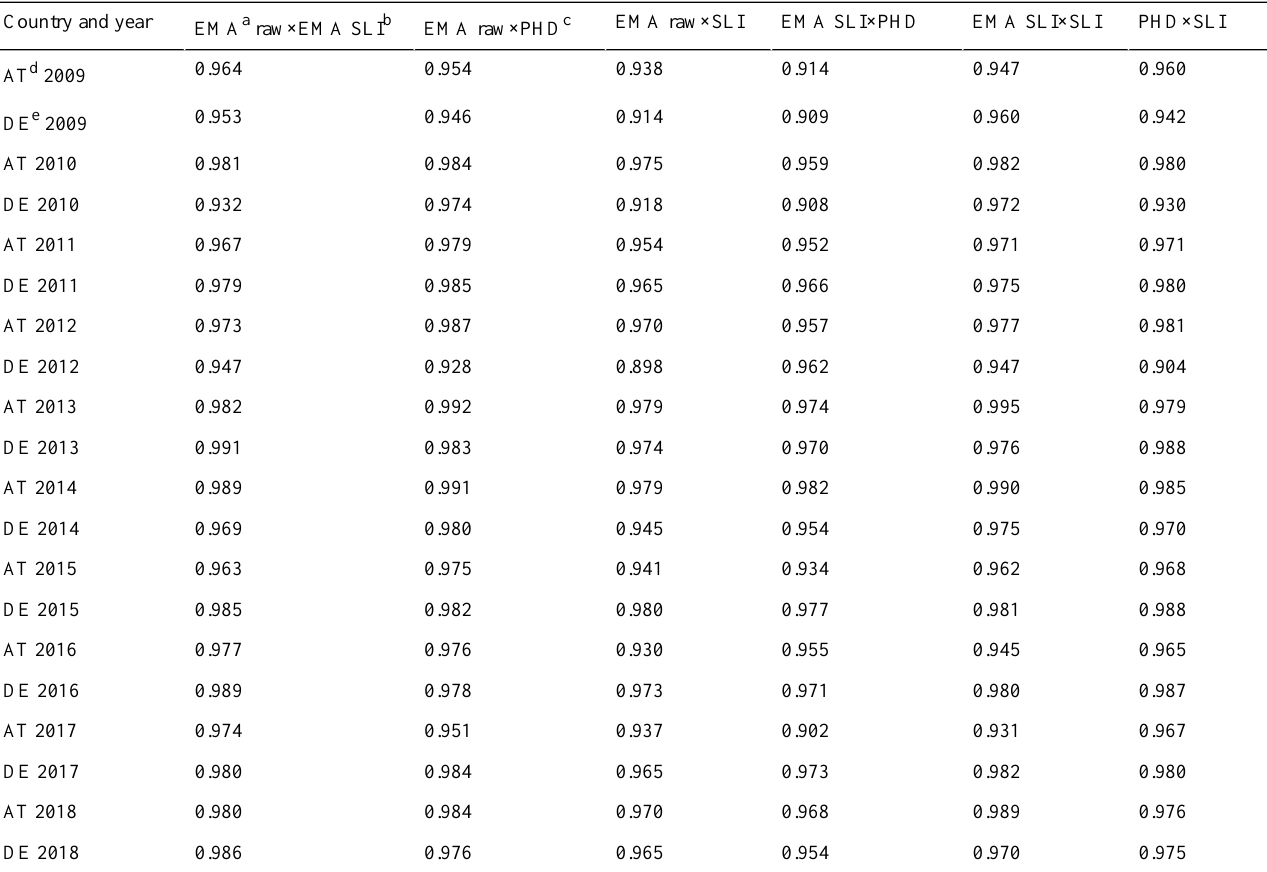
Table 3. Pearson correlation coefficients for the birch ( Betula ) pollen season for the 4 symptom score calculation methods for Austria and Germany from 2009 to 2018. Note the high correlation values for every